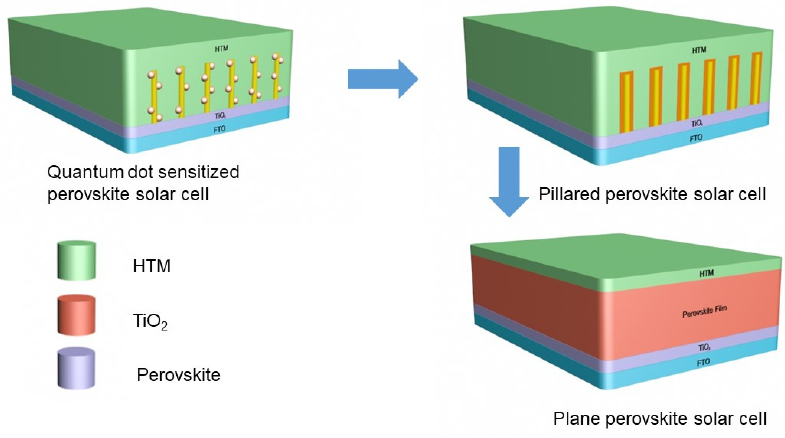
Figure 1. Development of the device structure of a perovskite solar cell.